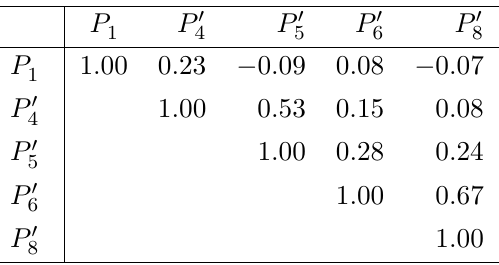
Table 13 . Statistical correlation matrix for the P (